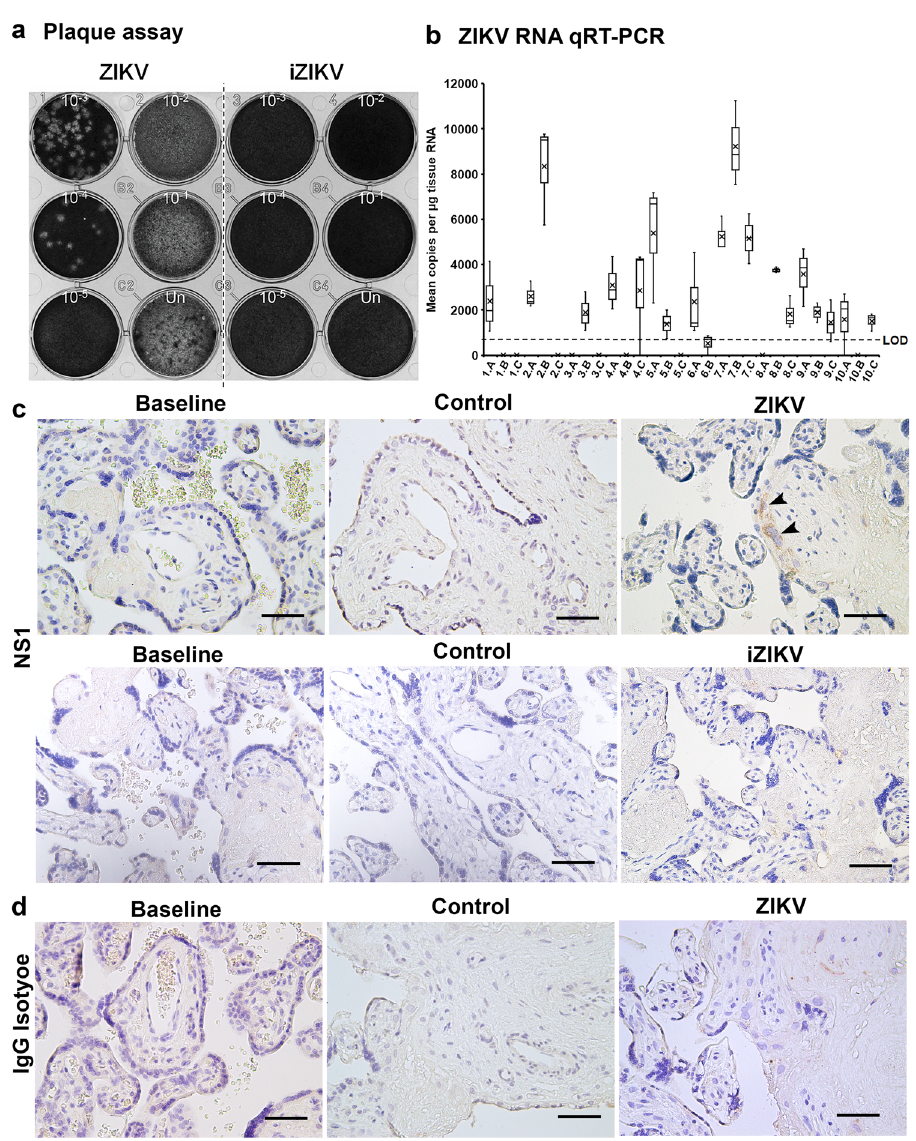
Fig. 2 ZIKV infection in perfused cotyledons. a Plaque assay validation of viral stocks depicted in grayscale. Vero cells were inoculated with 100 µ l of Undiluted (Un) and as annotated 10-fold serial dilutions of ZIKV and iZIKV in parallel. b Quantitative real-time PCR (qRT-PCR) analysis for ZIKV RNA. A-C represent the three biopsies collected and analyzed from each ZIKV perfused cotyledon (1-10). Box-plots represent the median in the centerline, upper and lower quartiles at top and bottom of box, min/max points as whiskers and the mean as x. LOD represents the limit of detection. c Staining for ZIKV NS1 in samples collected at baseline and following perfusion. NS1 staining is visualized with DAB in brown (arrowheads). d Staining ’ s conducted in parallel using an IgG isotype in place of NS1. Hematoxylin was used to counterstain nuclei in blue. Scale bars = 50 µ